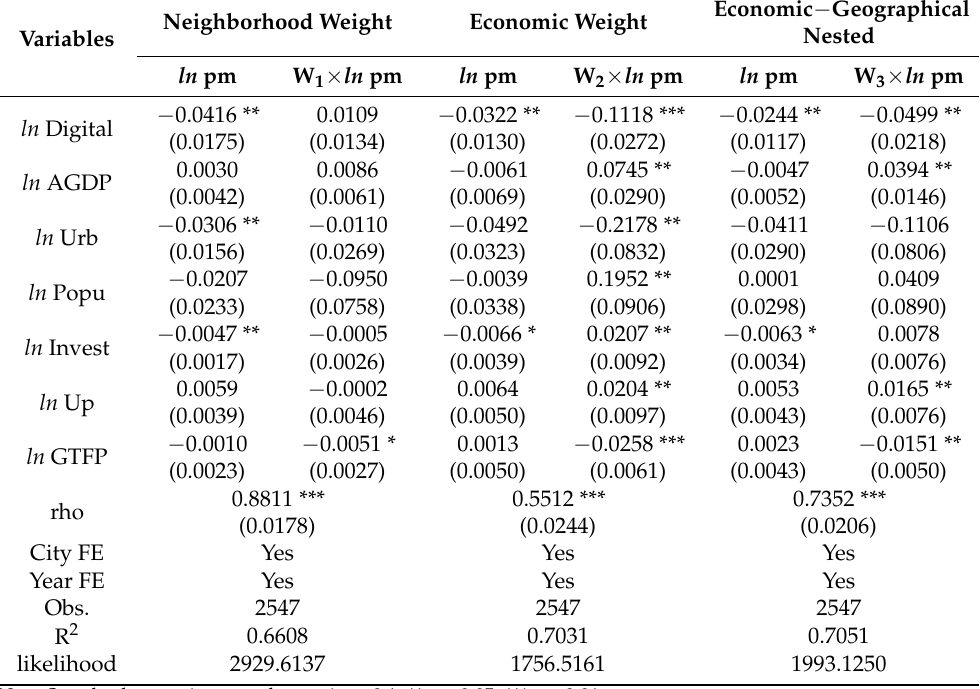
Table 6. Impact of the digital economy on PM 2.5